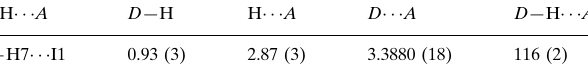
Hydrogen-bond geometry (A˚ , (cid:2)